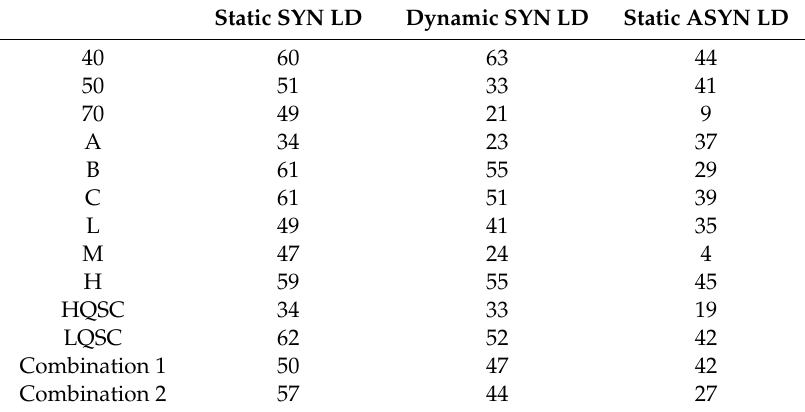
Table 2. Speed-ups in % provided by the asynchronous computing (ASYN) with respect to the level decomposition